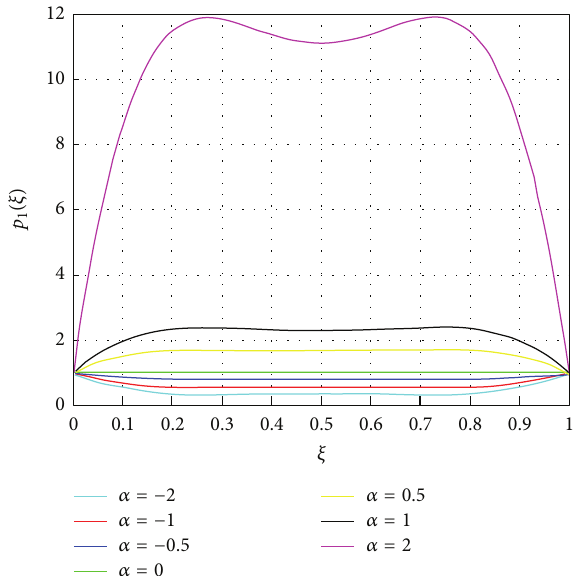
Figure 4: Variation of the beam stiffness for different values of 𝛼 . Figure 5: Variation of the beam mass for different values of 𝛼 .